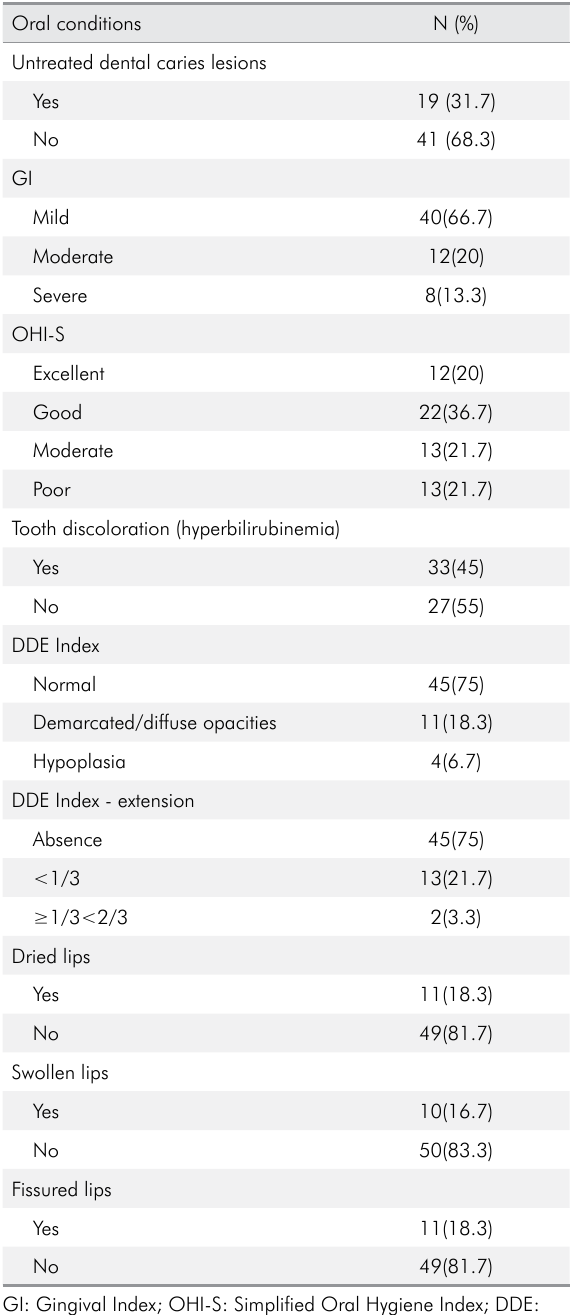
Table 2. Oral health conditions of pediatric liver transplant candidates (n =